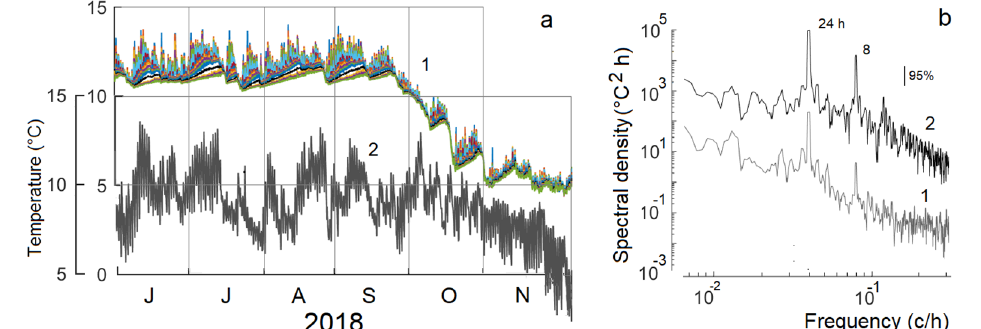
Figure 5. ( а ) Variability of water temperature in the surface layer of Lake El Sol in the area of the floating meteorological station (1) and air temperature on the western slope of the volcano crater (2), from June-November 2018. ( b ) The corresponding spectra of these time series. The vertical line in Figure 5b shows the 95% confidence interval.